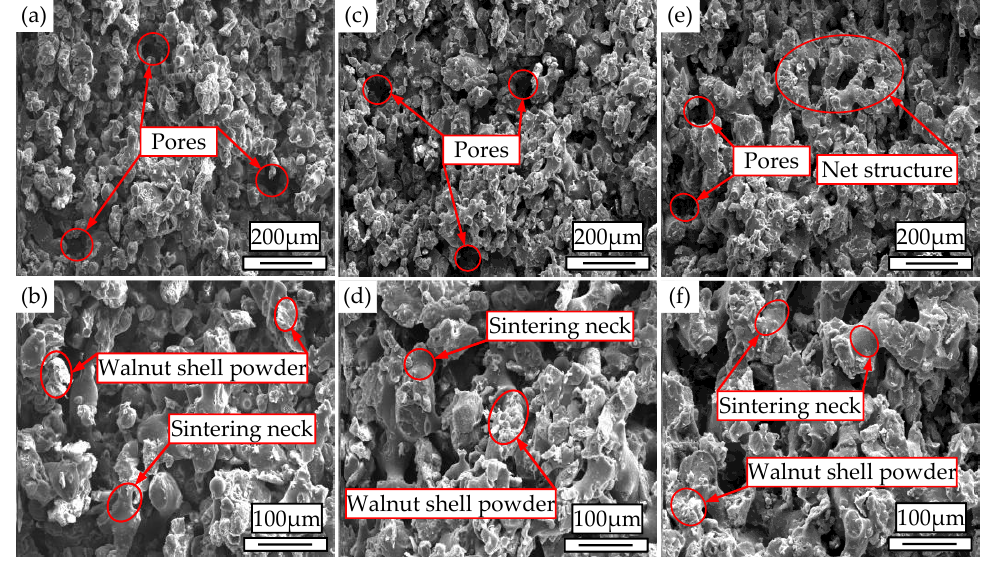
Figure 8. SEM images of cross-sections of the WSPC parts with walnut shell/Co-PES/Co-PA powder (40%/50%/8%) at ( a , b ) 76 °C; ( c , d ) 84 °C; and ( e , f ) 92 °C.